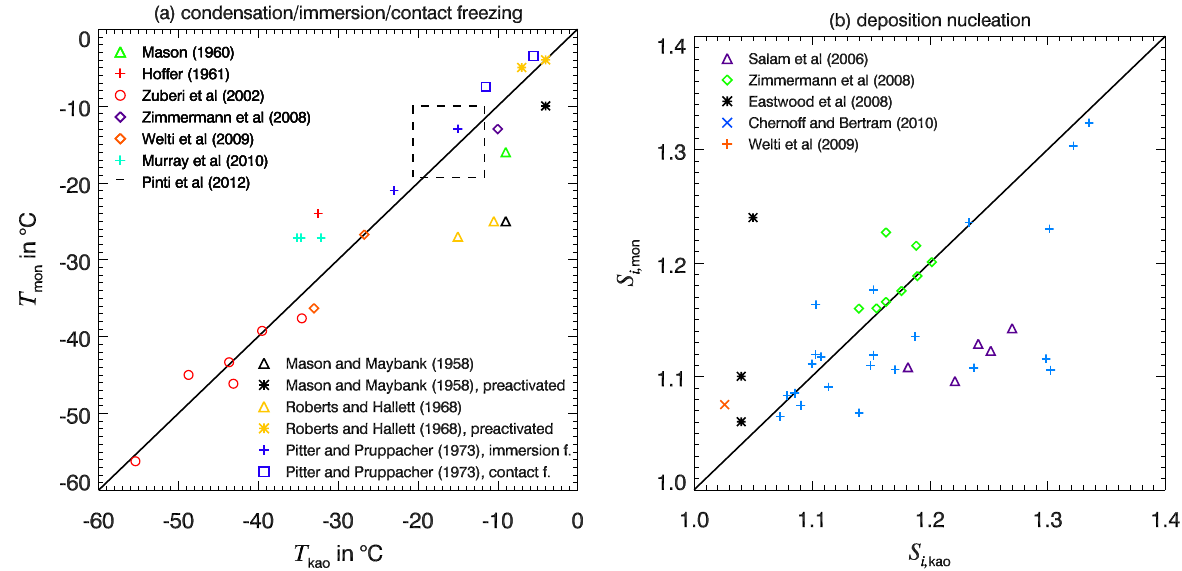
Fig. 6. (a) Freezing temperatures (onset or median) for kaolinite and montmorillonite under comparable experimental conditions. Includes immersion freezing experiments (Hoffer, 1961; Pitter and Pruppacher, 1973; Murray et al., 2010) and presumed condensation freezing experiments at water-supersaturated conditions (Zimmermann et al., 2008; Welti et al., 2009). The data by Welti et al. (2009) for 100 and 800nm-sized particles are interpolated to ≈ 5% supersaturation over water. For the mixing-cloud chamber experiments by Mason and Maybank (1958) and Mason (1960), the nucleation mode is uncertain. Zuberi et al. (2002) measured immersion nucleation in aqueous ammonium sulfate droplets, data are shown for the same weight percentages of kaolinite and montmorillonite. Pinti et al. (2012) show results for several different kaolinites and montmorillonites, as indicated by the dashed lines. (b) Saturation ratios at deposition nucleation onset for kaolinite and montmorillonite under comparable experimental conditions and temperature (for Welti et al. (2009), the data have been interpolated to the same temperatures). In Zimmermann et al. (2008)’s study, ice nucleation on montmorillonite was observed only at or slightly above water saturation, but no liquid water was seen. All other data in (b) are for deposition nucleation experiments, water